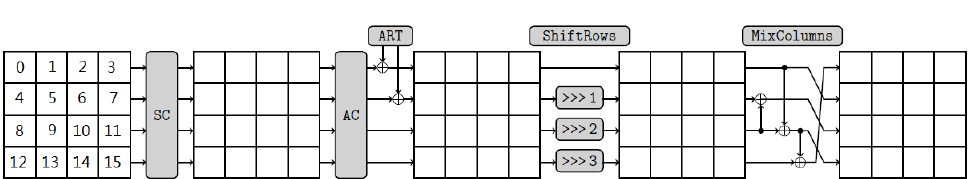
Figure 2: The SKINNY Round function: SubCells (SC), AddConstants (AC), Ad- dRoundTweakey (ART), ShiftRows (SR) and MixColumns